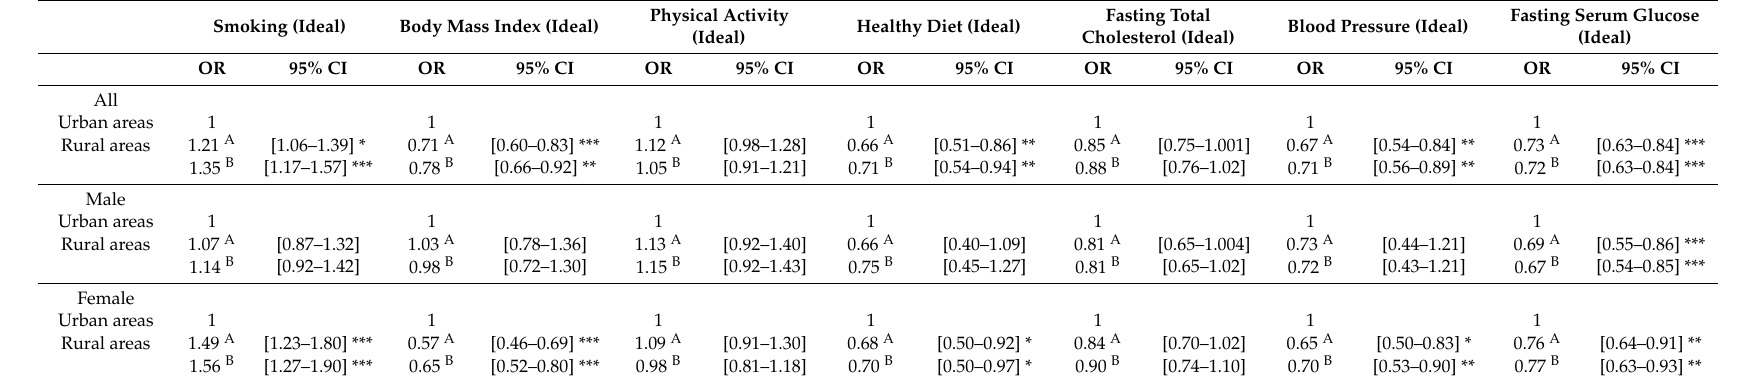
Table 3. The relation between the place of residence and ICH components altogether, and according to